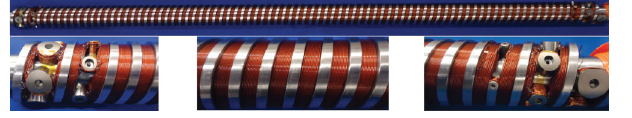
FIG. 10. HSCU magnet after winding. The pin extensions have been removed in preparation for epoxy impregnation.